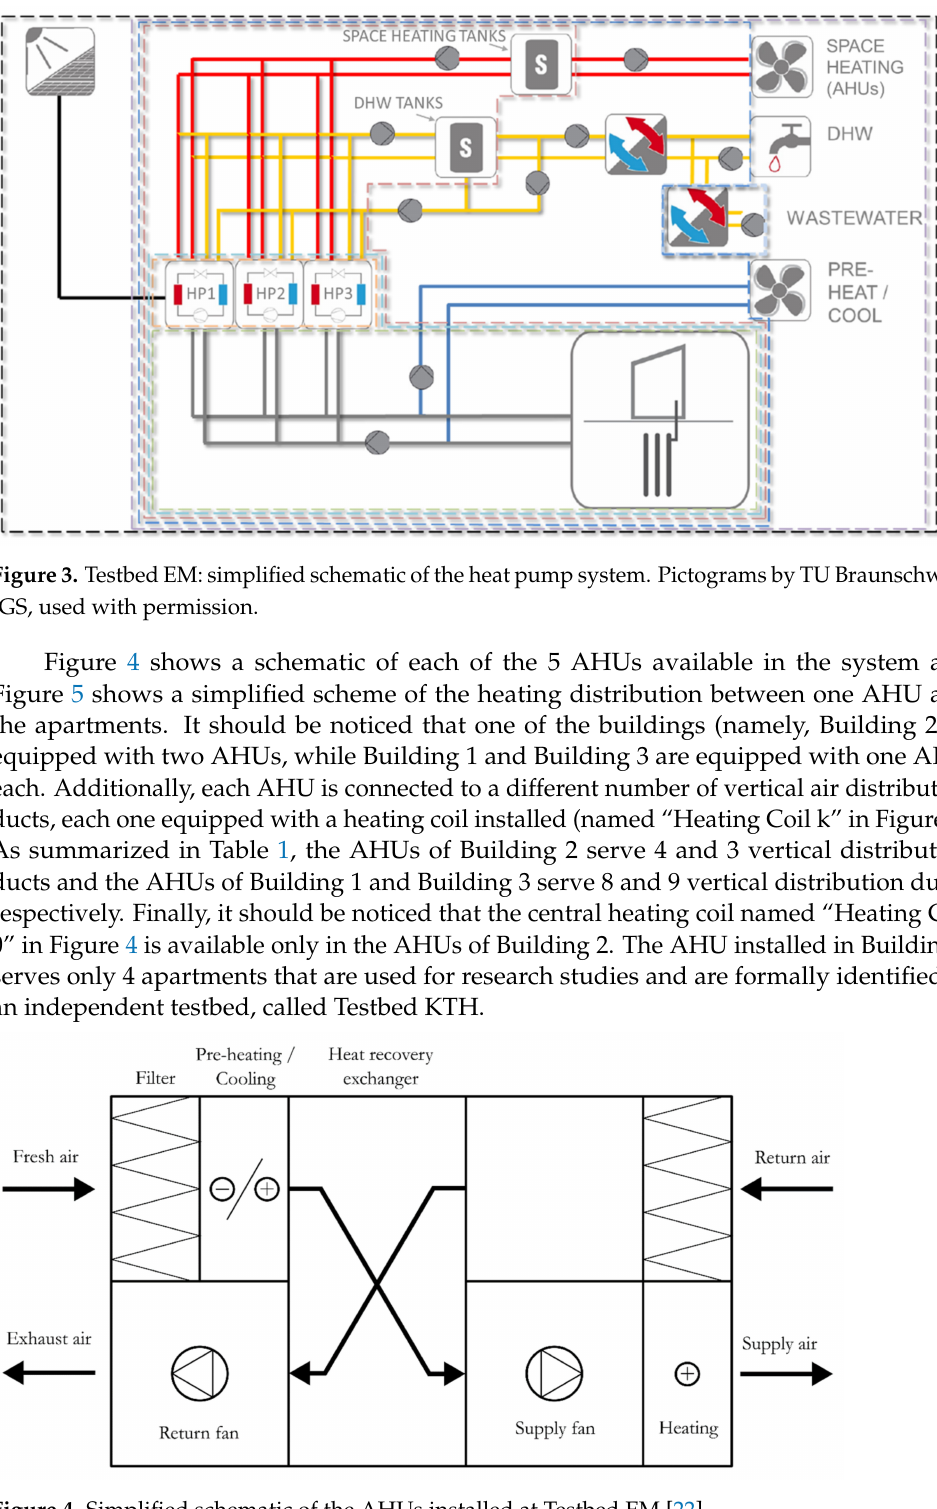
Figure 4. Simplified schematic of the AHUs installed at Testbed EM